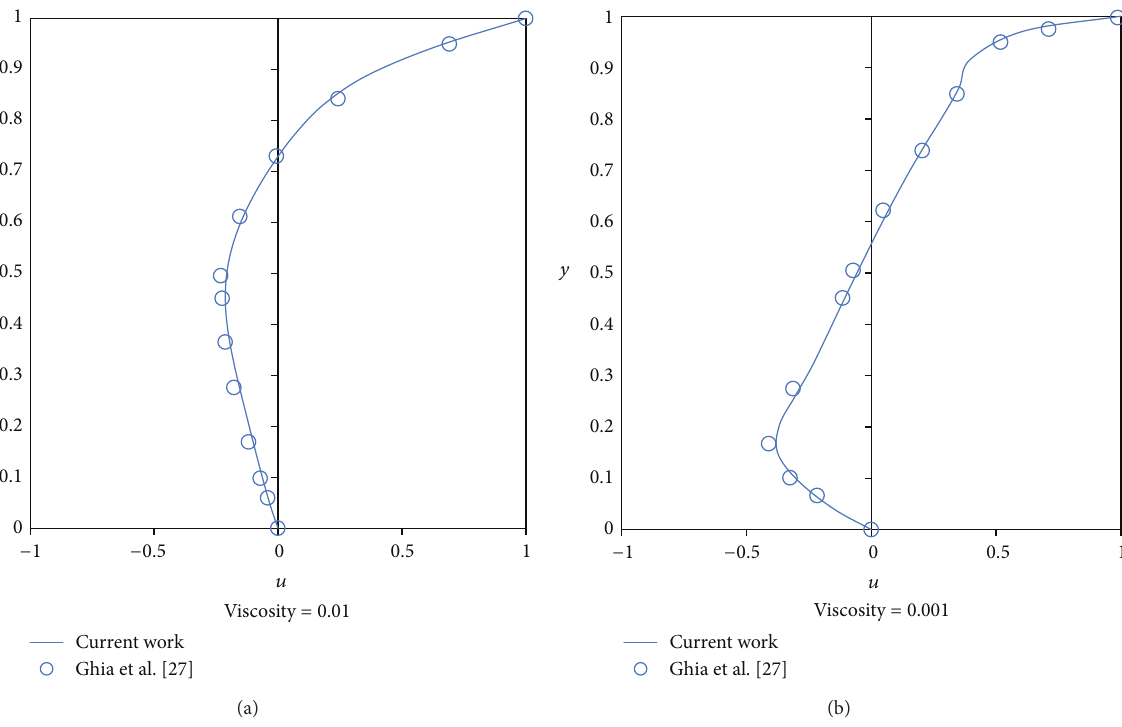
Figure 4: Comparison of the horizontal velocity component mean at viscosity of 0.01 (a) and 0.001 (b) with the benchmark solution in [27].